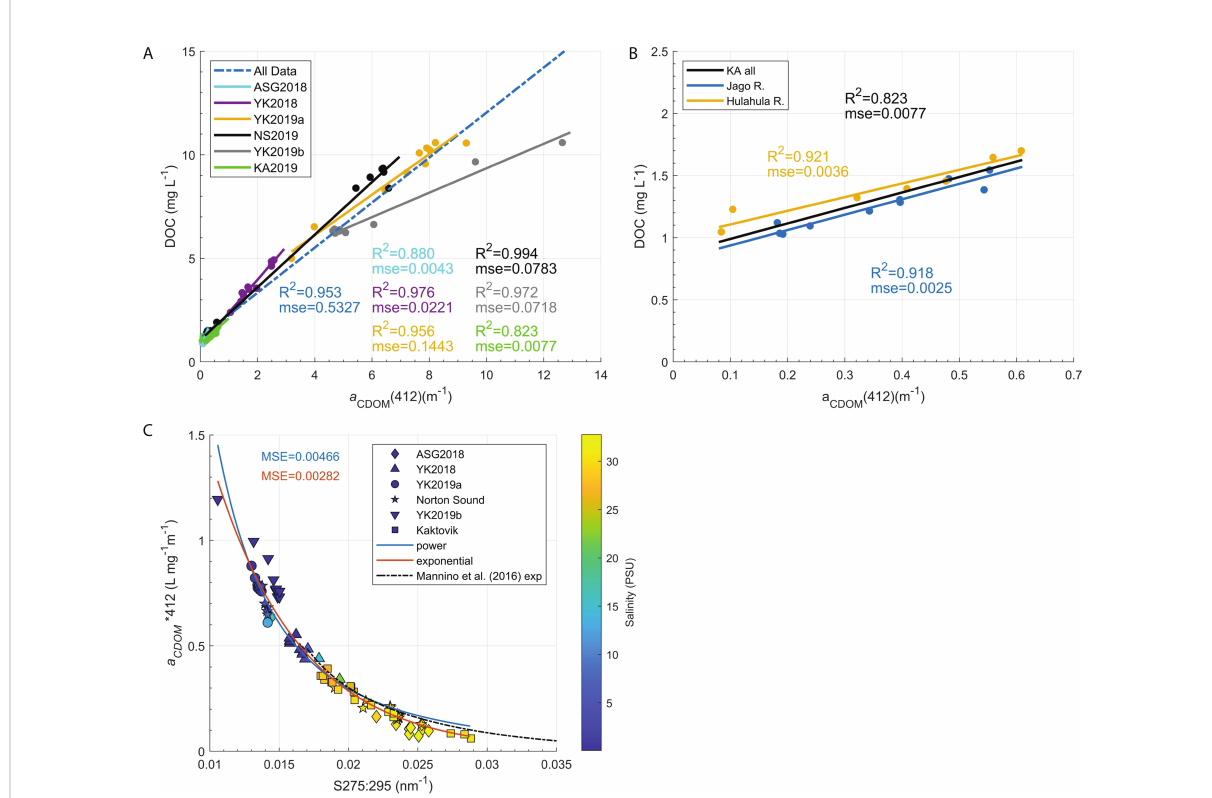
FIGURE 6 (A) Linear Relationships of a CDOM (412)(m -1 ) versus DOC concentrations (mg L -1 ). The blue dashed line is a single fi t to all the data where the other lines are fi ts partitioned by fi eld deployment. (B) Subset of Kaktovik a CDOM (412)( m -1 ) versus DOC (mg L -1 ) Linear Relationships further partitioned by proximity to the Jago and Hulahula Rivers. (C) Non-linear fi ts to the relationship of S 275:295 (nm -1 ) and a CDOM *412(L mg -1 m -1 ) where the symbols correspond to each fi eld deployment and the salinity (PSU) at each point de fi ned by its color. Solid blue and red curves are power and exponential fi ts to RSWQ data respectively, while the dashed line is an exponential fi t derived from the Mannino et al. (2016) data